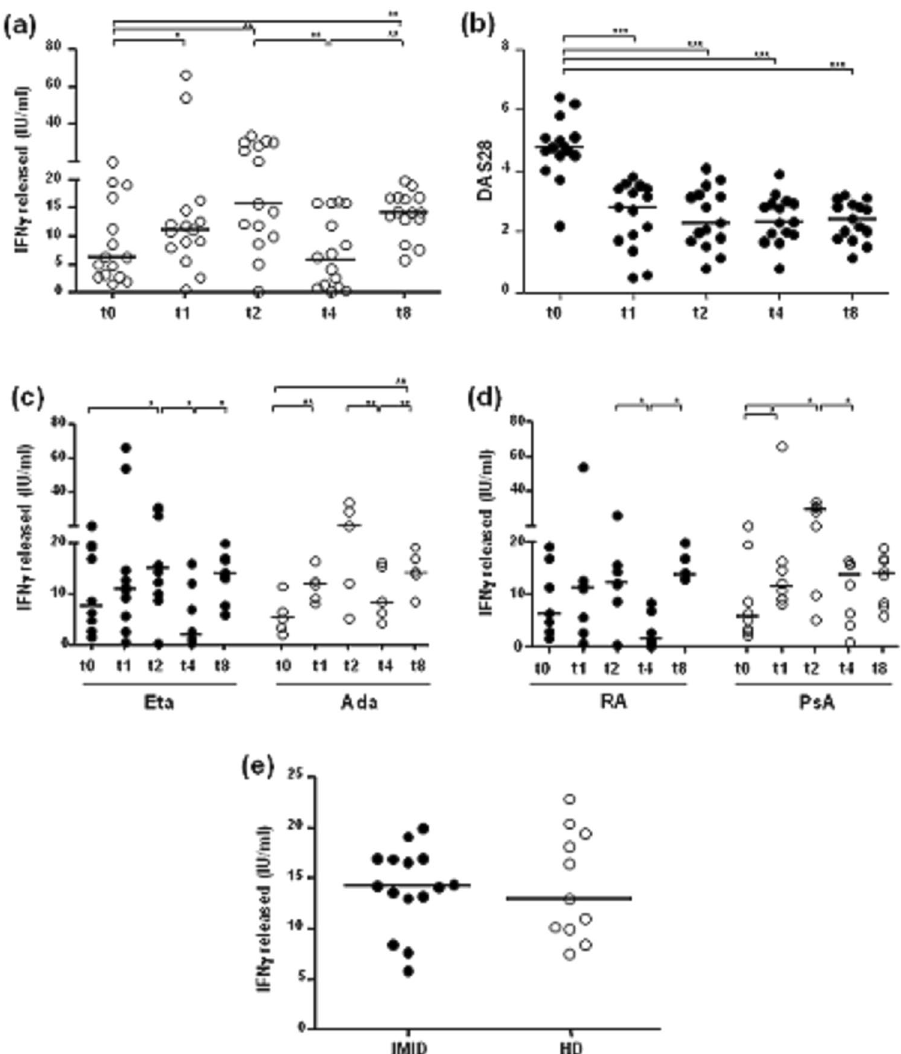
Figure 1. Mitogen-induced IFN γ response from patients undergoing treatment with TNF antagonists. The release of IFN γ in response to phytohemagglutinin (PHA) was evaluated after 18 hours of incubation using the QuantiFERON TB Gold-In Tube (QFT-GIT; Cellestis GmbH, QIAGEN Inc. Valencia, CA, USA) assay, according to the manufacturer’s instructions. The figure shows the mitogen-induced IFN γ response during follow-up. (a) IFN γ response (IU/mL) after mitogen stimulation was assessed in 15 IMID subjects before and after 1, 2, 4, and 8 years of biological agents. (b) Changes in the DAS28 score in the IMID subjects at the different time points of the follow-up period. (c) The analysis of mitogen-induced IFN γ response was assessed according to the type of biological agent in patients treated with Eta (n = 10, black circle) and in those treated with Ada (n = 5, white circle). (d) The analysis of mitogen-induced IFN γ response was assessed according to the type of inflammatory disease in 7 patients with rheumatoid arthritis (RA, black circle) and in 8 patients with psoriatic arthritis (PsA, white circle). (e) The IFN γ response was assessed by comparing IMID subjects (n = 15) after 8 years of treatment with TNF antagonists and healthy donors (HD, n = 11). Horizontal bars represent the median values. Statistical analysis was calculated by Wilcoxon Rank test for longitudinal data and by non- parametric Mann-Whitney test to compare IMID and HD subjects. Significant p -values are